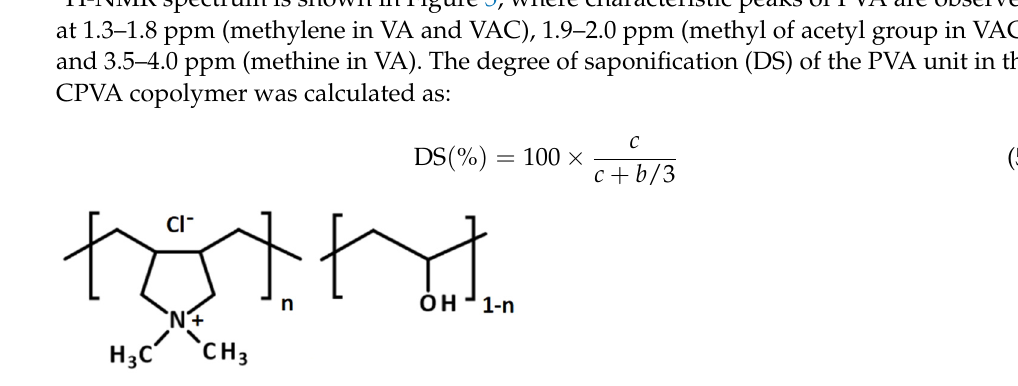
Figure 4. The chemical structure of poly(vinyl alcohol- co -diallyldimethylammonium chloride) (CPVA).